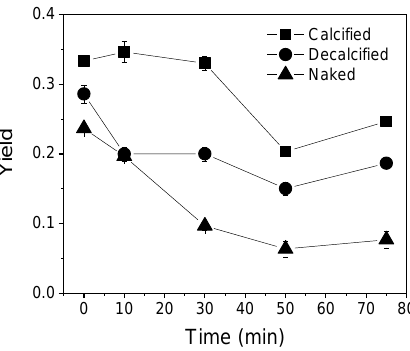
Figure 5. The time course of quantum yield of calcified, de- calcified and naked cells of E. huxleyi under full-spectrum so- lar radiation (noontime, average PAR, UV-A and UV-B were